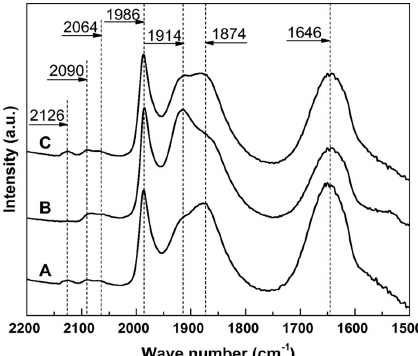
Figure 15. In situ DRIFTS of CO adsorption over the reduced 1.0% Pd catalyst: A: pretreatment with O 2 , adsorption of CO and purged with Ar; B: H 2 treatment of A, readsorption of CO and purged with Ar; C: O 2 retreatment of B, readsorption of CO and purged with Ar. All the experiments were carried out at 283 K. Reprinted from J. Catal., 321, L. Ouyang, P. Tian, G. Da, X. Xu, C. Ao, T. Chen, R. Si, J. Xu, Y. Han, The origin of active sites for direct synthesis of H 2 O 2 on Pd/TiO 2 catalysts: Interfaces of Pd and PdO domains, 70–80, Copyright (2018), with permission from